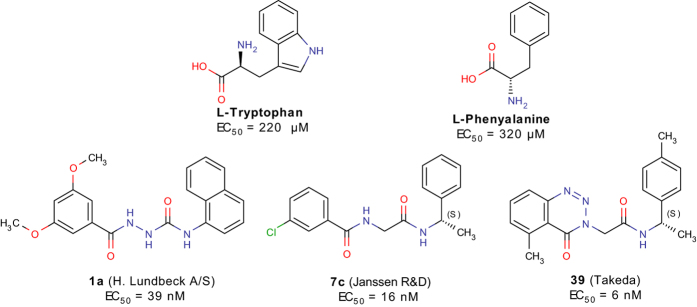
Chemical structure of the two endogenous amino acids L-Trp and L-Phe, and the most potent surrogate agonists 1a and 7c, and 39 from three series published by H. Lundbeck A/S11, Janssen R&D1314, and Takeda15 respectively.